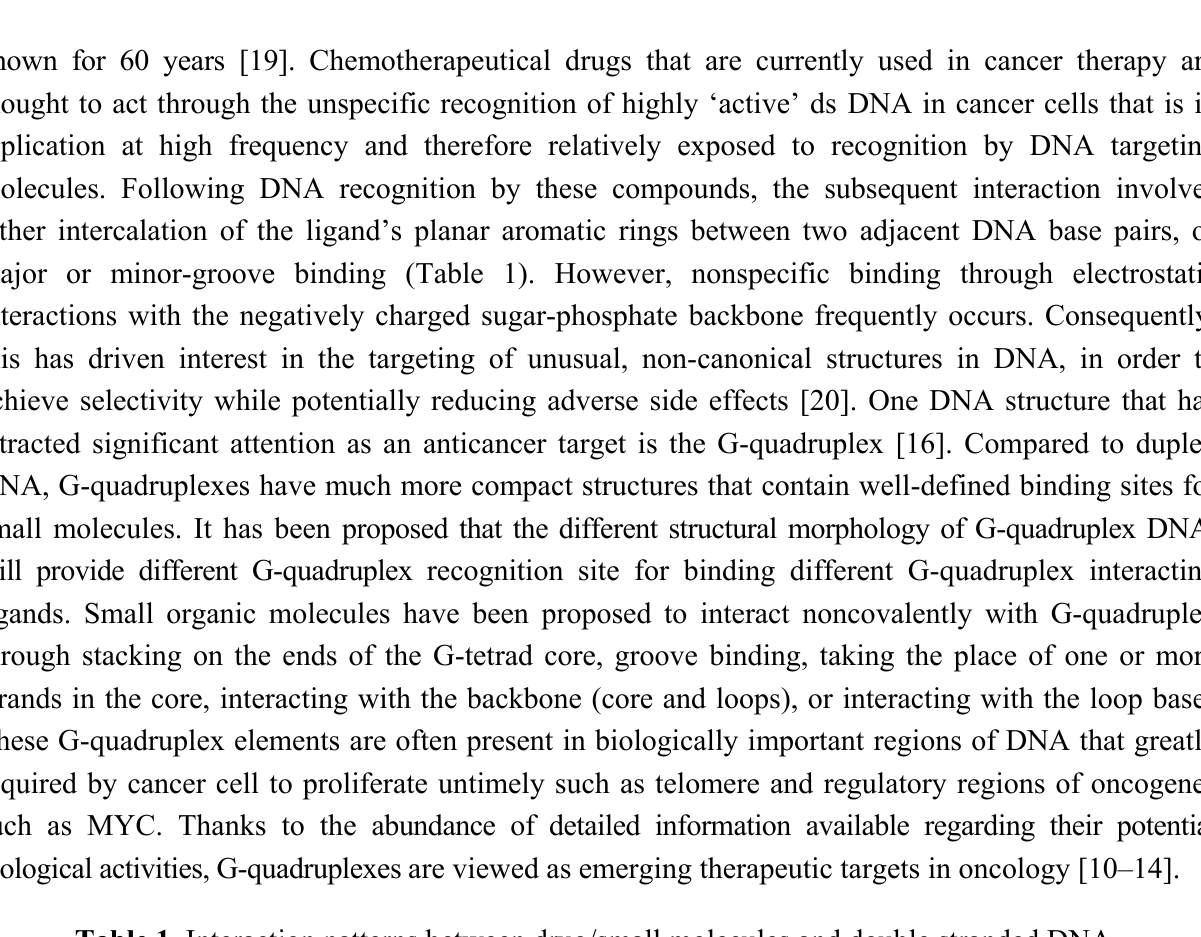
Table 1. Interaction patterns between drug/small molecules and double stranded